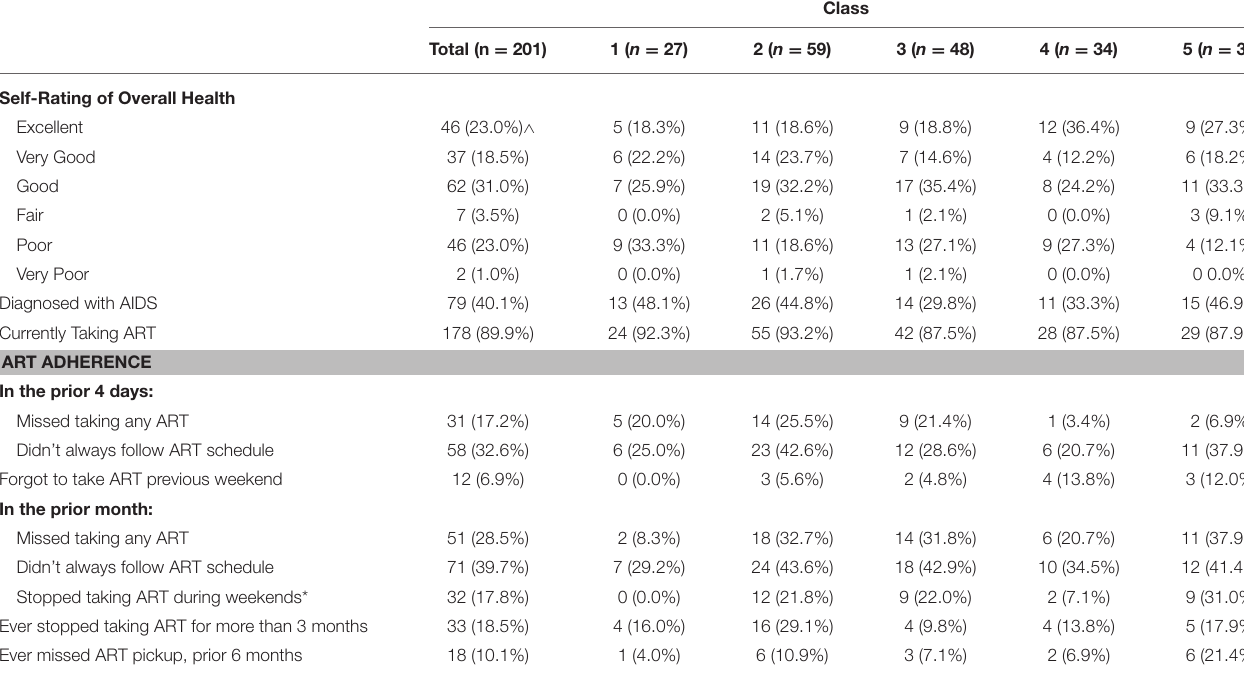
TABLE 4 | ART adherence and health indicators (by